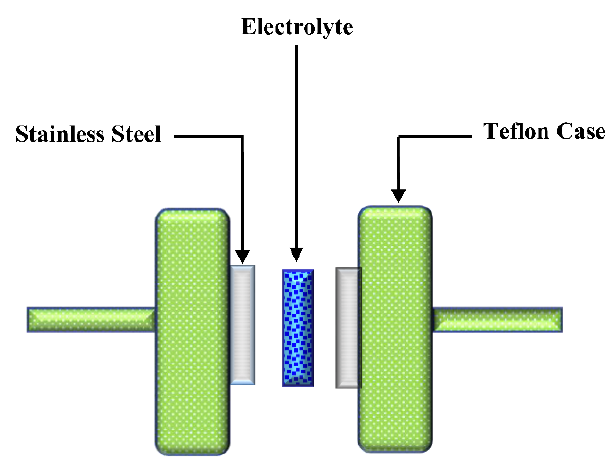
Figure 1. The schematic drawing of the two stainless steel electrodes design for the investigation of transference number measurement (TNM) and linear sweep voltammetry (LSV).